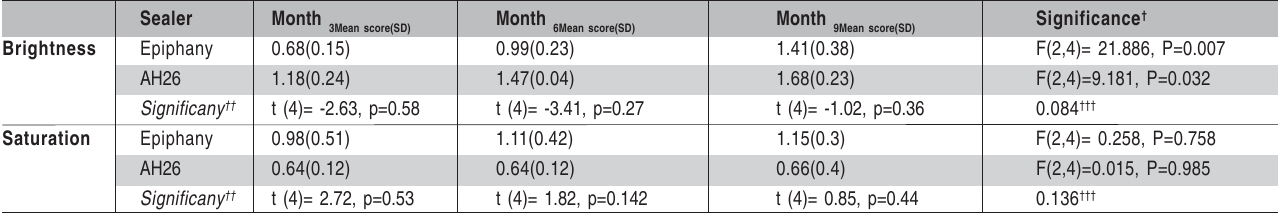
Table1. Changing trends of saturation and brightness during the study in Epiphany and AH26 sealers calculated for whole crown.